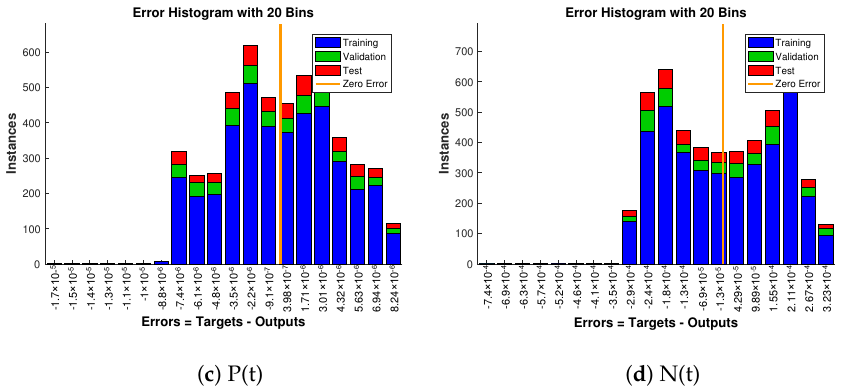
Figure 13. Error histogram analysis in relation to the target data and the approximate solutions for case 1.